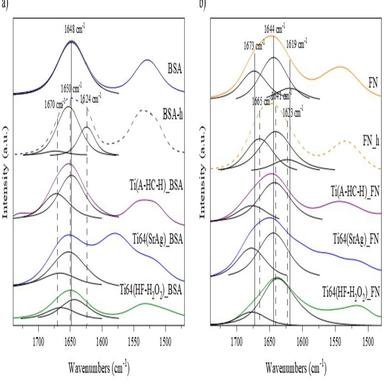
Amide I and Amide II bands region of BSA (a) and FN (b), as native or denatured proteins and after adsorption on the different samples, with deconvolution of the Amide I band. The component positions of the native (solid lines) and denatured (dashed lines) proteins are also reported.